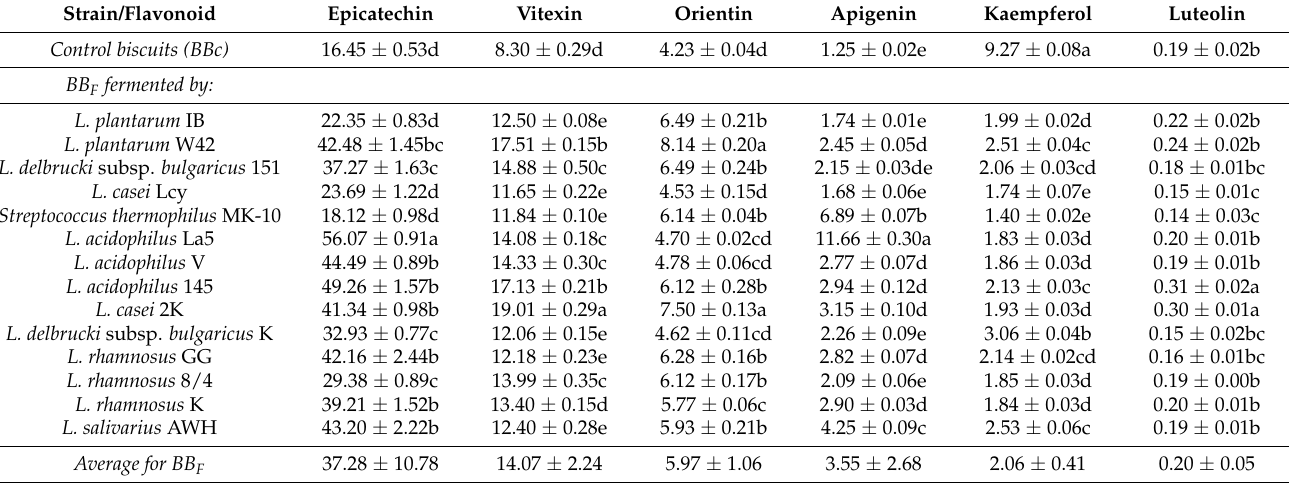
Table 5. The content of flavonoids ( µ g/g DM) in buckwheat biscuits prepared from not fermented (BB C ) and fermented flours (BB F ) by selected lactic acid bacteria after in vitro digestion. Data are expressed as mean ± standard deviation ( n = 3). Means in each column followed by different letters are significantly different ( p < 0.05) based on the one-way analysis of variance